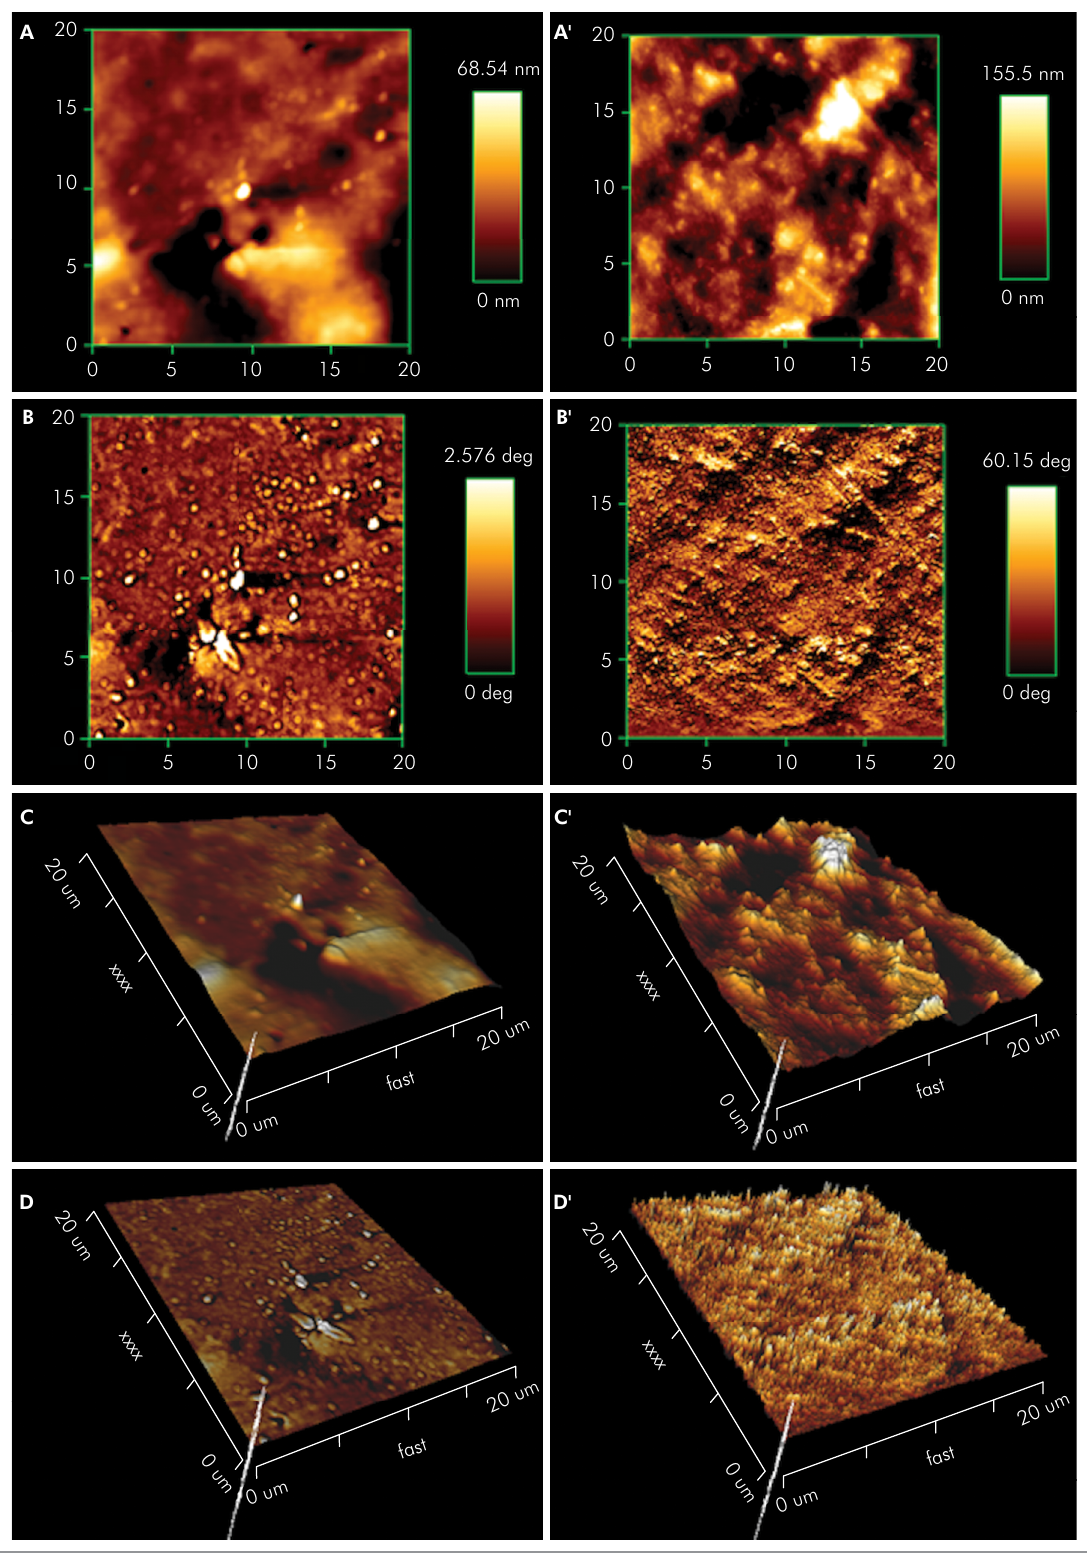
Figure 1. Photomicrographs in AFM of specimen surfaces from Group XT, before and after pH-cycling, respectively being: A and A’ – two-dimensional images in height; B and B’ – two-dimensional images of lock-in phase; C and C’ – three-dimensional images in height; D and D’ – three-dimensional images of lock-in